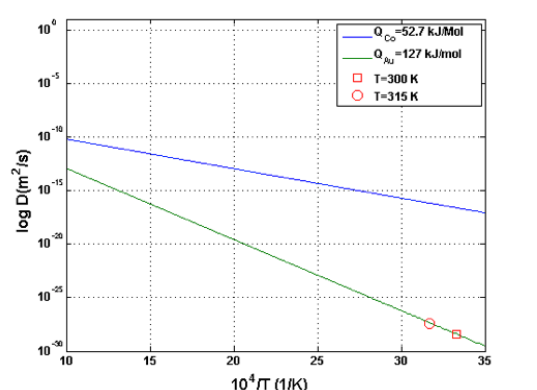
Figure 8. Effects of a variance in temperatures and activation energy on calculated D